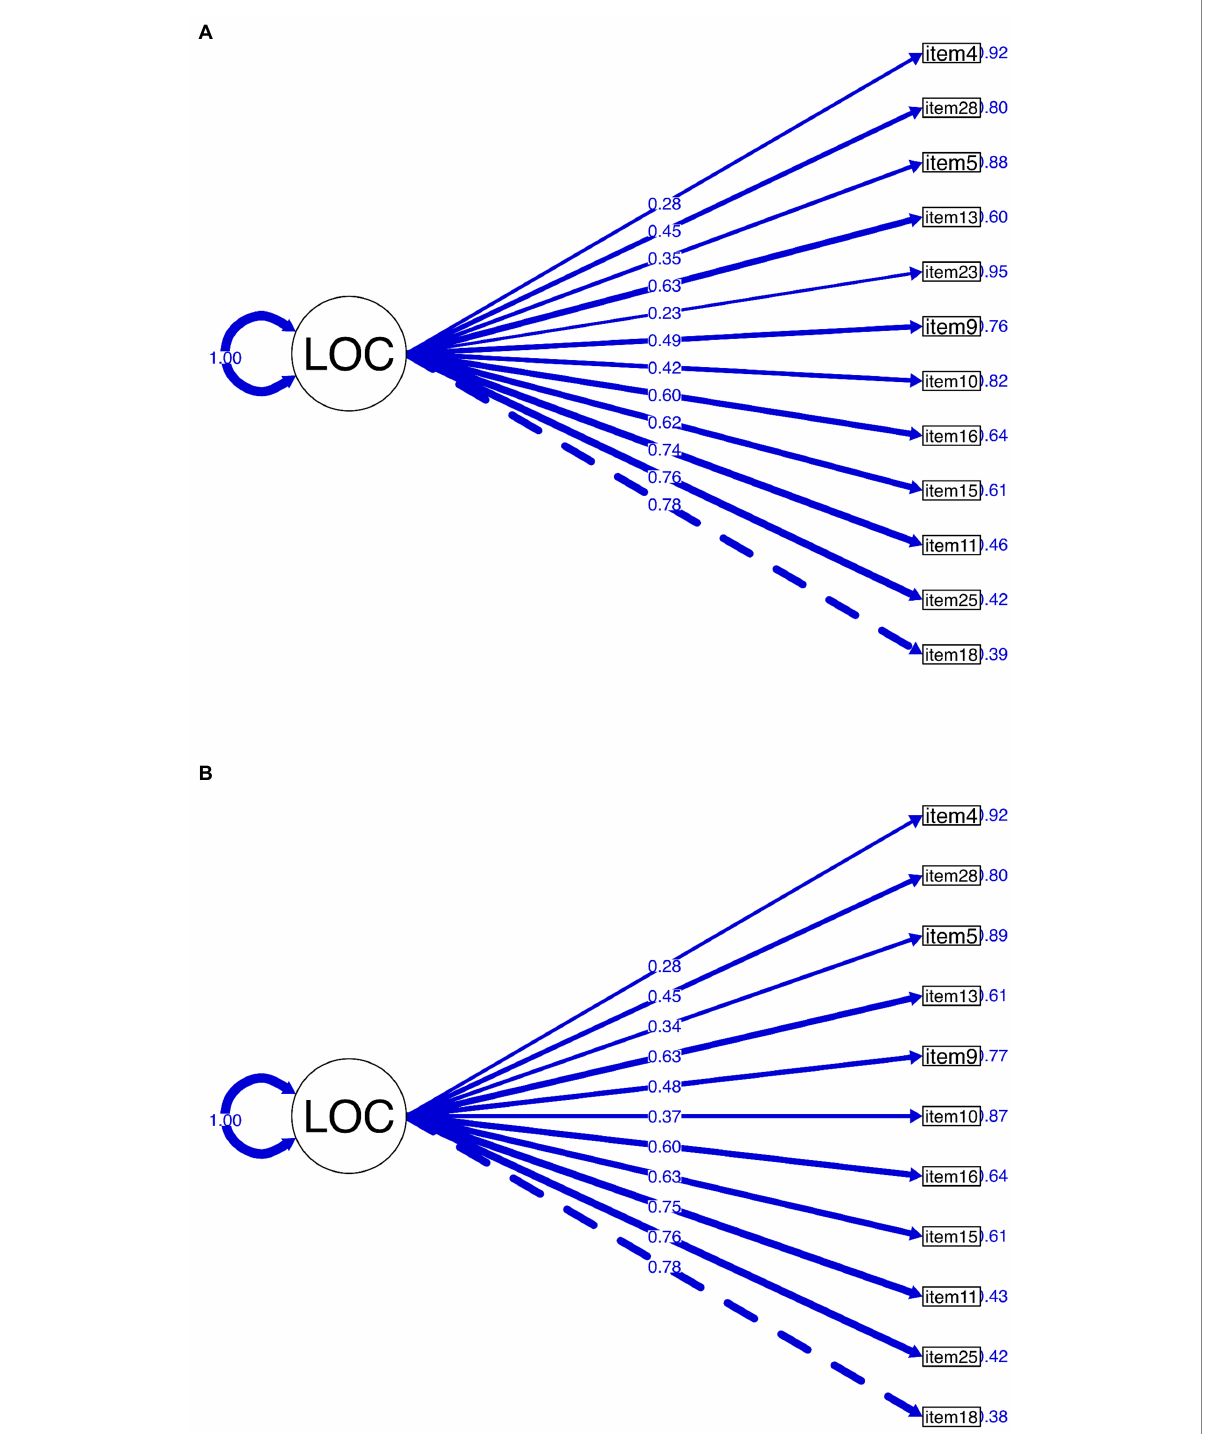
FIGURE 4 Confirmatory factor analysis on the one-factor model of Bangla Rotter’s I-E scale. (A) One-factor model with 12 items, (B) one-factor model with 11